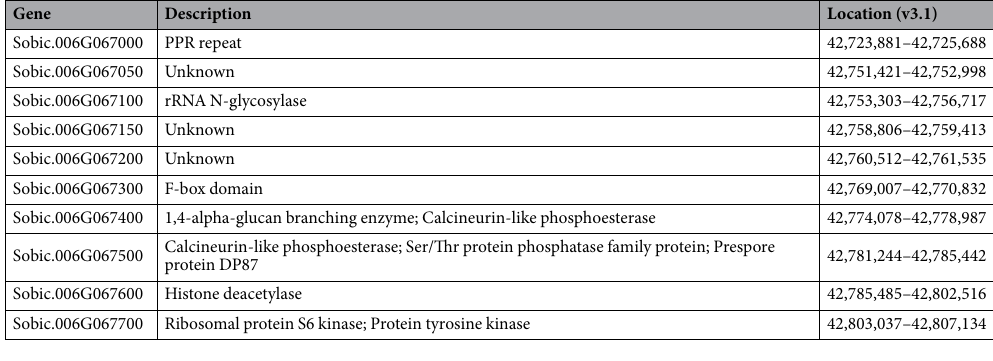
Table 2. Genes in the Delimited Region of Dw2 .